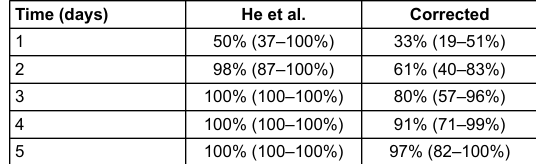
Table 2: The fraction of presymptomatic infections that are traced if we look back days from symptom onset using the published and corrected infectivity profiles. The computed quantity f(t) is described in equation (1). Values in parentheses represent 95% confidence intervals of f(t) when accounting for the uncertainty in the infectivity